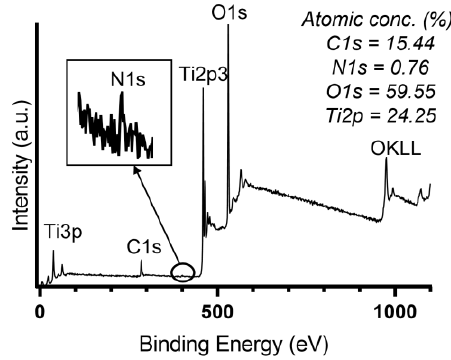
Figure 3. Survey XPS spectrum of the TiNT-U 24 composite.